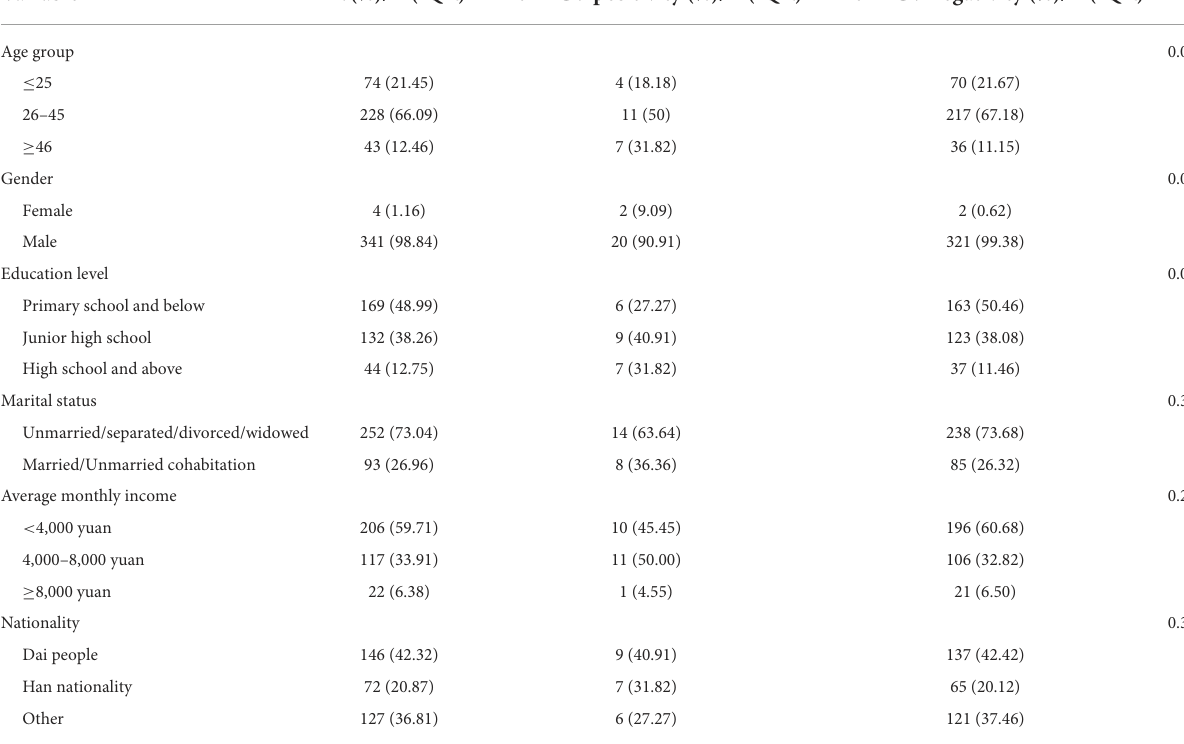
TABLE 2 Demographic and economic characteristics by anti-HCV positivity among ATS users ( N = 345).